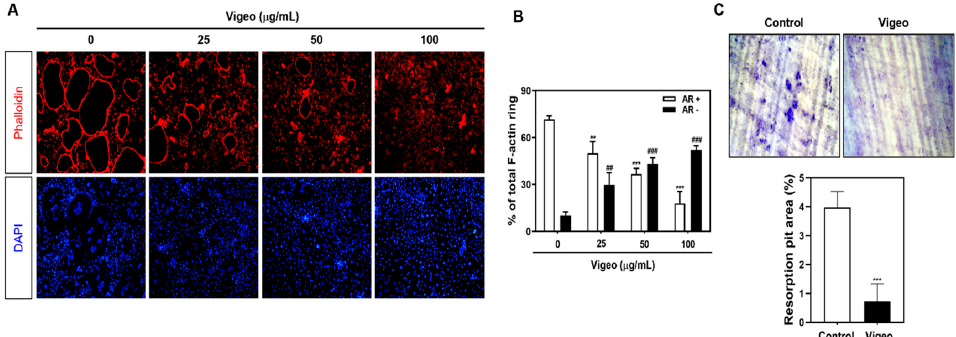
Figure 4. Vigeo suppresses the F-actin ring formation and bone-resorbing activity of mature osteoclasts. ( A ) Bone marrow macrophages (BMMs)were cultured with M-CSF (30 ng/mL) and receptor activator of nuclear factor-B ligand (RANKL) (100 ng/mL) in the presence of the indicated concentrations of Vigeo. The cells were fixed, permeabilized, and stained with phalloidin and 4 (cid:48) ,6-diamidino-2-phenylindole (DAPI). The cells were examined under a confocal laser scanning microscope. ( B ) Normal actin ring (AR+) osteoclasts and disrupted actin ring (AR − ) osteoclasts were counted and compared with the total number of osteoclasts that contain three or more nuclei. The graph shows the comparison between relative percentage of osteoclasts that express AR+ and AR − . ** p < 0.01 and *** p < 0.001 versus AR+ osteoclasts in control group; ## p < 0.01 and ### p < 0.001 versus AR − osteoclasts in control group. ( C ) Mature osteoclasts from the co-culture system were seeded in dentin slices for 48 h with or without Vigeo (100 µ g/mL). Cells attached to the hydroxyapatite-coated plate were removed, and the plates were photographed under a light microscope. *** p < 0.001 versus the